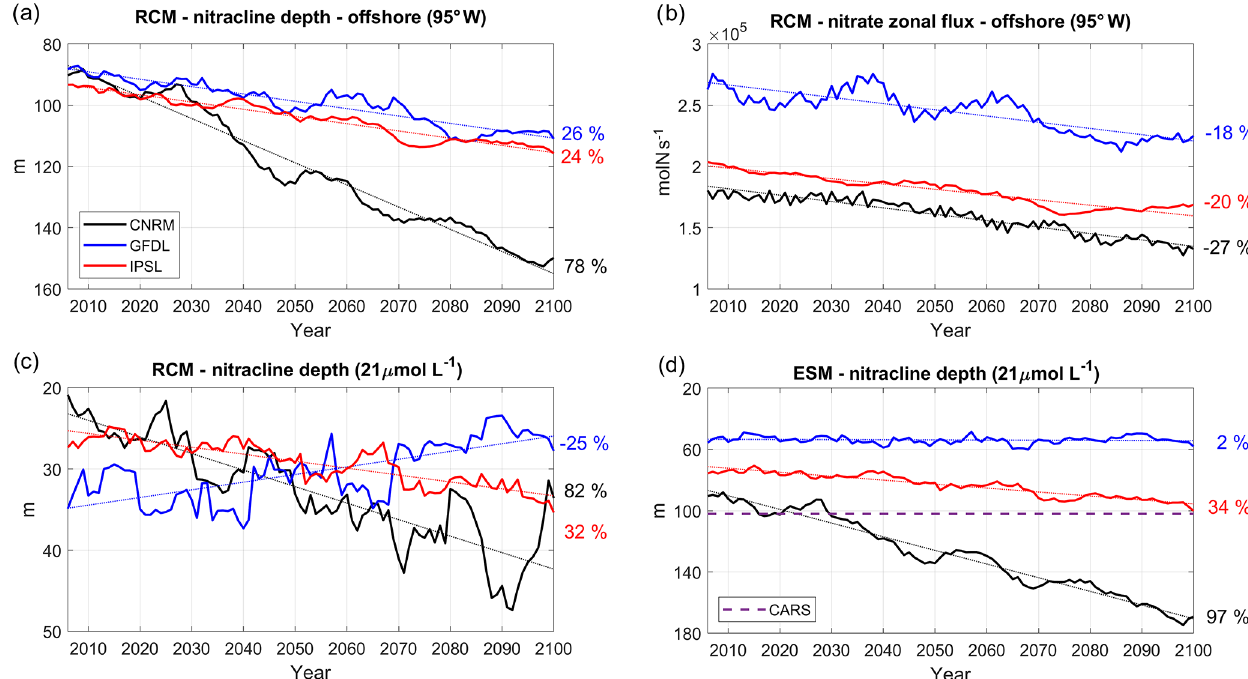
Figure 11. (a) Nitracline depth (i.e., depth of the nitrate 21µmolL − 1 isosurface) at 95 ◦ W (averaged between 2 ◦ N and 10 ◦ S), (b) eastward nitrate flux (mols − 1 ) at 95 ◦ W (averaged between 2 ◦ N and 10 ◦ S, 50–200m depth), and (c) nitracline depth (i.e., depth of the nitrate 21µmolL − 1 isosurface) averaged in a 100km wide coastal box, for the three RCMs (CNRM in black, GFDL in blue, IPSL in red) and (d) for the ESMs. The time series are filtered using a 10-year moving average. CARS (dashed purple line) climatological values are shown in (d)